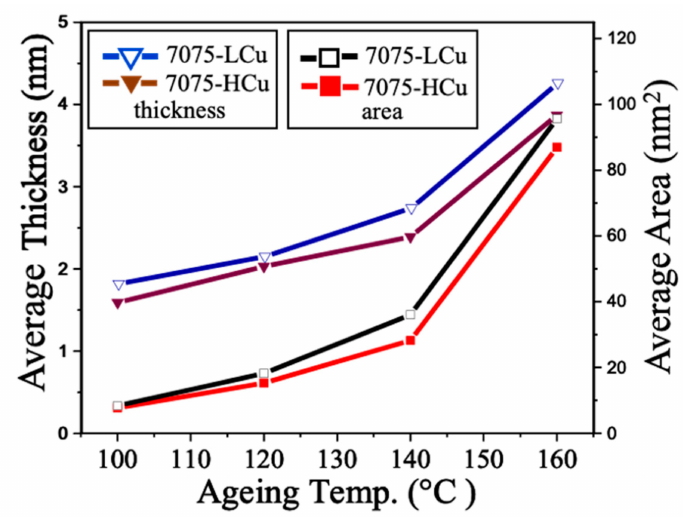
Figure 11. Plot of average area and average thickness of precipitate versus aging temperature for the two alloys subjected to different PA